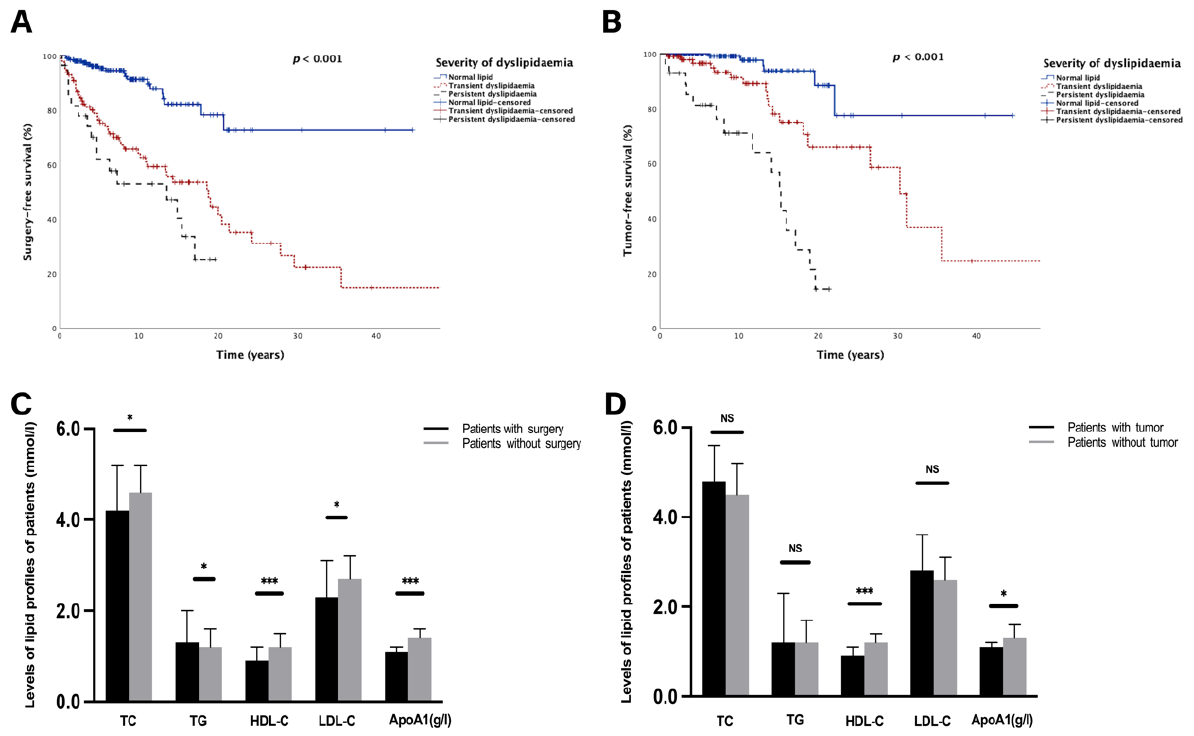
Figure 3. Comparison of lipid levels and lipid profiles in patients with different long-term outcomes. ( A , B ) Kaplan–Meier survival curve presenting the surgery-free survival ( A ) and tumour-free survival ( B ) in different groups based on the severity of dyslipidaemia. ( C ) Bar graphs of long-term levels of TC, TG, HDL-C, LDL-C, and ApoA1 between patients who were surgery-free and those who underwent surgery. ( D ) Bar graphs of long-term levels of TC, TG, HDL-C, LDL-C, and ApoA1 between tumour-free and tumour-bearing patients. NS, no significance. Significant p -value < 0.05. * p < 0.05, *** p < 0.001. Surgery-free survival was defined as the period from diagnosis to UC-related surgery. Tumour-free survival was defined as the period from diagnosis to tumorigenesis. Transient dyslipidaemia was defined as occurrence of dyslipidaemia not more than twice during the whole following period. Persistent dyslipidaemia was defined as times of dyslipidaemia occurring not less than three times during the whole following period.